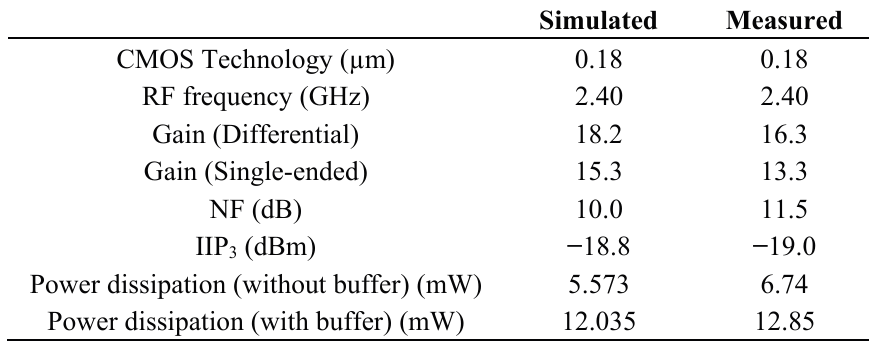
Table 1. Performance summary of the receiver front-end.